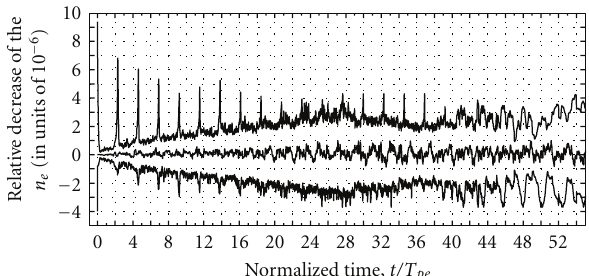
Figure 1: The time variations of maximal (top curve) and minimal (bottom curve) values of the relative decrease of the electron concentration, computed at all grid cells of the simulation region. Also, the time variation of the relative decrease of the electron concentration, calculated at the center of the simulation region (middle curve). The results were obtained for the first situation with the start from the completely electrically neutral state. The values are given in units of 10 − 6 . The normalized time, t/T pe , that is, the time in units of the equilibrium period of Langmuir oscillations of electrons, T pe , is shown on the